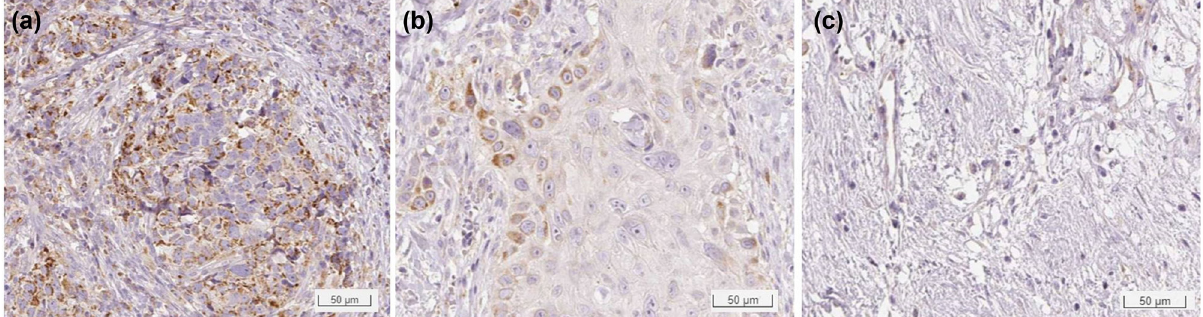
Figure 2: MTHFD2 protein relative expression analysis detected by immunohistochemistry assay ( a ) MTHFD2 protein high expression; ( b ) MTHFD2 protein median expression; ( c ) MTHFD2 low expression.